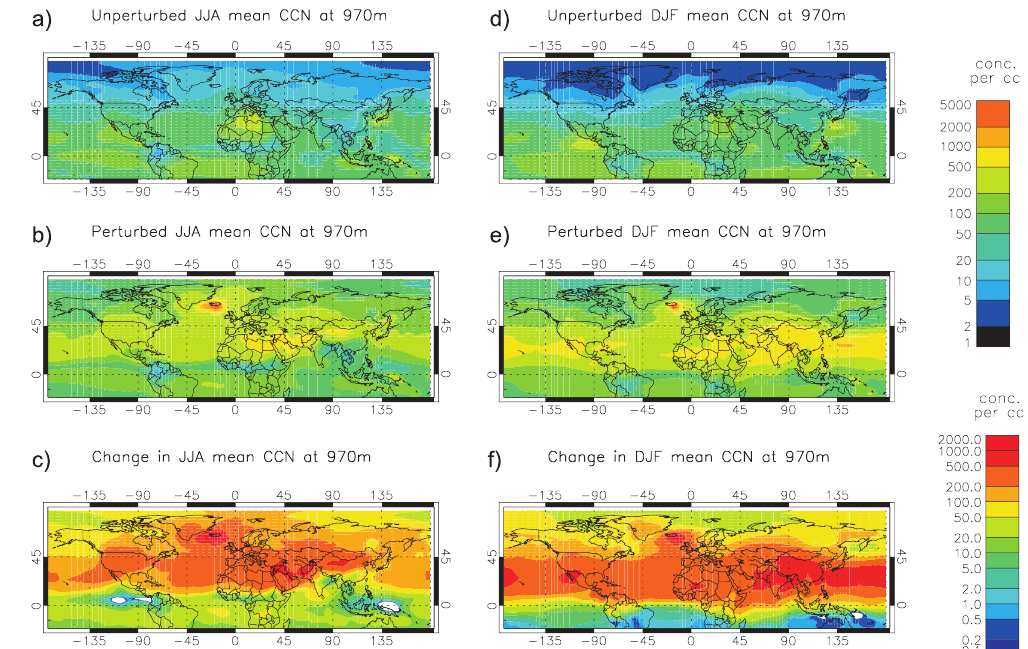
Fig. 12. Simulated 3-month mean CCN concentrations (radius > 35nm, supersaturation=0.22%) per cubic centimeter (per cc) for L-s: (a) unperturbed run, (b) perturbed run, (c) absolute change; and for L-w: (d) unperturbed run, (e) perturbed run, (f) absolute change. JJA=June-July-August;